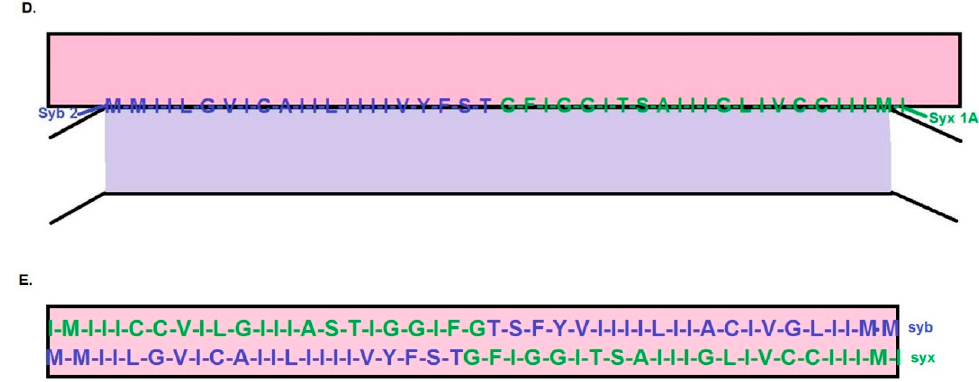
Figure 1. Proposed membrane organization of syb and syx for the BAT models. ( A ) The pre-docking state of a synaptic vesicle (lavender) is shown prior to contact with the plasma membrane (pink). The intra-membrane, hydrophobic domains of vesicle-associated syb and plasma membrane-associated syx (in dark blue with the single letter code denoting the amino acid sequences of the mouse proteins here and in all later panels) are shown at the interface between the inner and outer hemi-bilayers. These intra-membrane sequences are proposed to adopt β -structure which is preserved in panels ( B – E ). Palmitoylation of C (cysteine) residues is not depicted. The C-ends of syb and syx are presumably modified to eliminate their charge ( B ) Once SNARE zippering commences and the synaptic vesicle contacts the plasma membrane, it initiates a translocation of the hydrophobic domains of syb and syx from the inter-leaflet position shown here toward the vesicle-plasma membrane interface as illustrated in C ( C ) This shows an intermediate state in which the hydrophobic domains of syb and syx are re-locating to the vesicle-plasma membrane interface ( D ) This is a cross-sectional representation of the docked and primed state of the synaptic vesicle-plasma membrane interface for the BAT model. Syb sequence is dark blue while syx is green. The syx partner for syb would sit behind the plane of this image, as would the syb partner for syx ( E ) “Top” view of the organization of syb-syx pairs of a docked and primed synaptic vesicle. This is the postulated end-to-end organization of the syb-syx pairs that one would observe by removing the external leaflet of the plasma membrane thereby exposing the elongated β -structure of these domains. Note that these images are drawn to accentuate the arrangement of syb and syx, first within their respective membranes and then at the interface between the vesicle and plasmalemma.